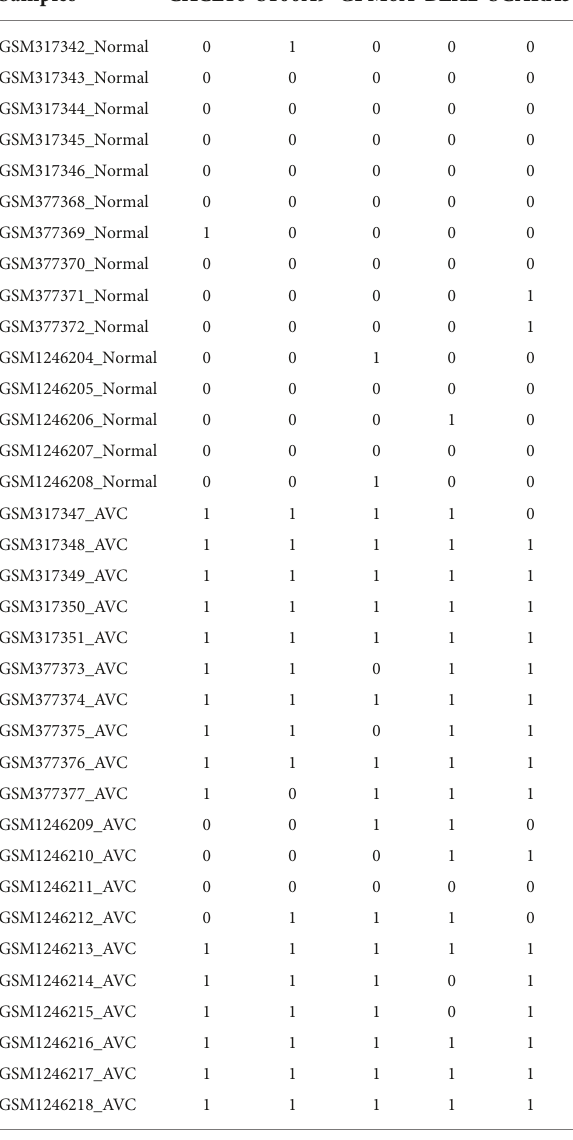
TABLE 3 Results of gene scores for all samples of the combined dataset of GSE12644 and GSE51472. Samples